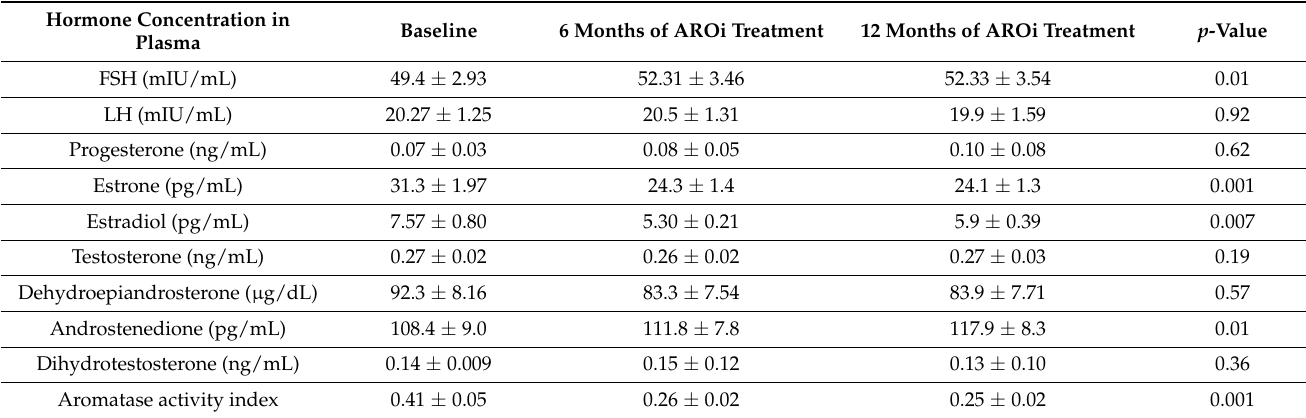
Table 4. Concentration of gonadotropins and androgens, progesterone and estrogens, and aromatase activity index in